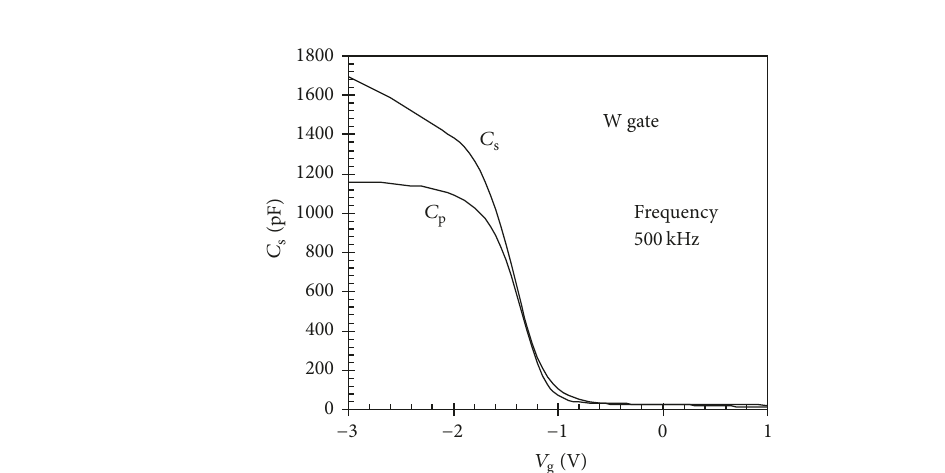
- V and 𝑅 - V characteristics for a W gate. p p